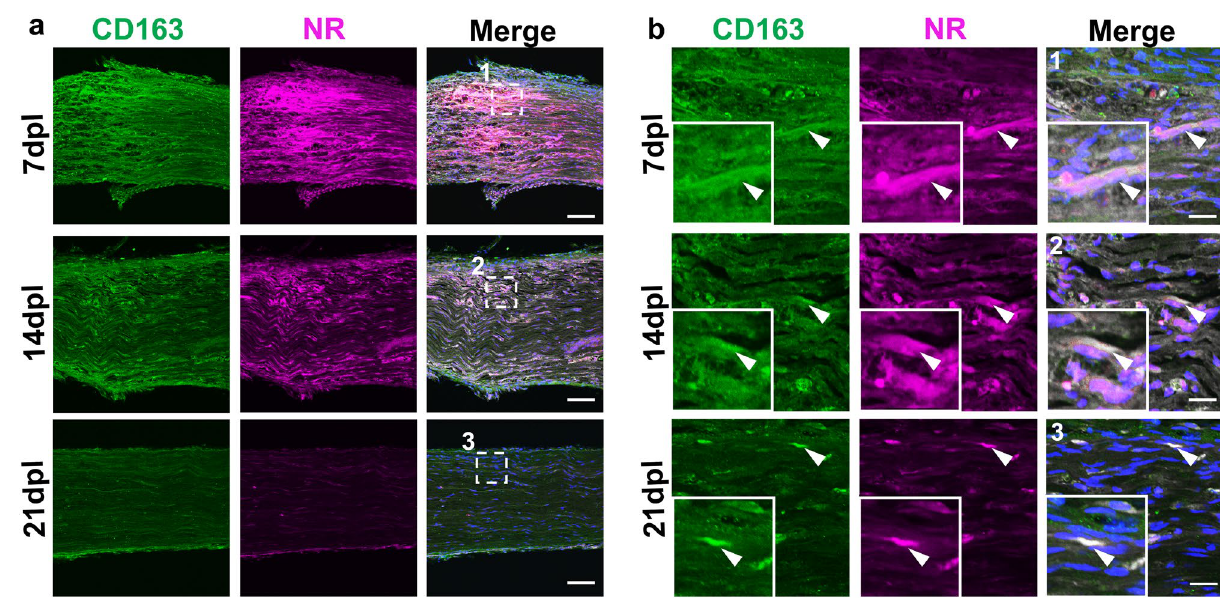
Figure 7. Neutral red (NR) colocalized with CD163-positive M2 type macrophages in demyelinated lesions. ( a ) Representative confocal images of NR (magenta) and immunofluorescence staining for macrophages labeled with anti-CD163 (green) at low ( a ) and high ( b ) magnification in areas with lysophosphatidylcholine injection at 7, 14 and 21 dpl (n = 3 mice per timepoint examined). ( b1–3 ) Enlarged images of ( a1–3 ) (white dotted square). CD163-positive cells colocalized with neutral red at each timepoint ( b , arrowhead). Insets Enlargements of double-positive cell. Nuclei were counterstained with Hoechst (blue). Scale bar, 50 µm ( a ) and 20 µm ( b